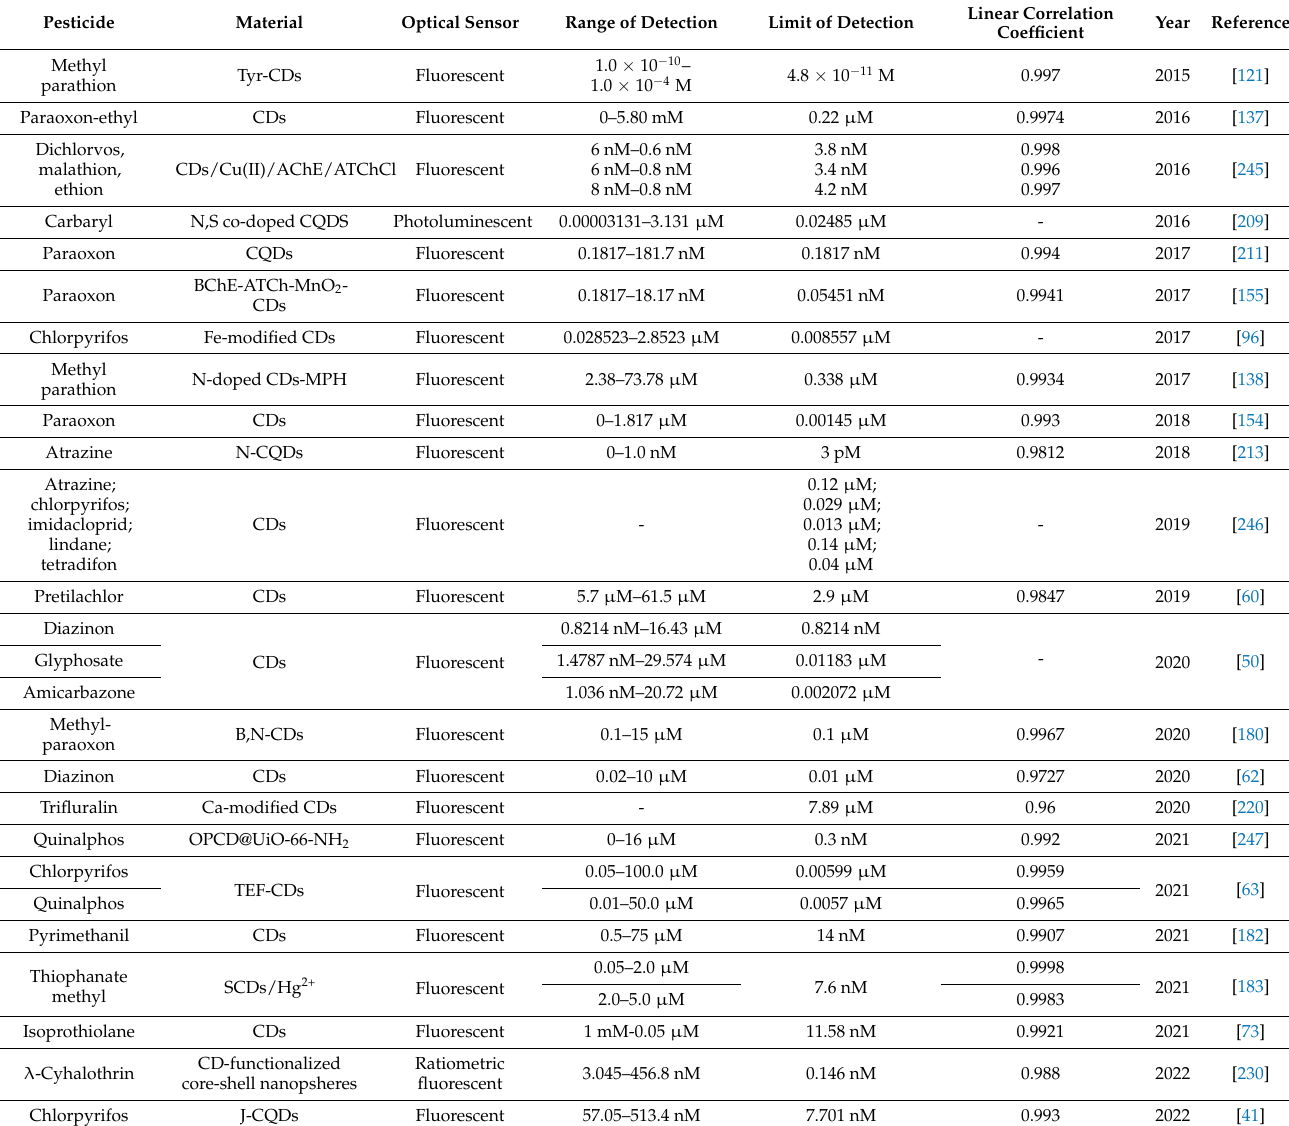
Table 12. Summary of the developed optical sensors for pesticides